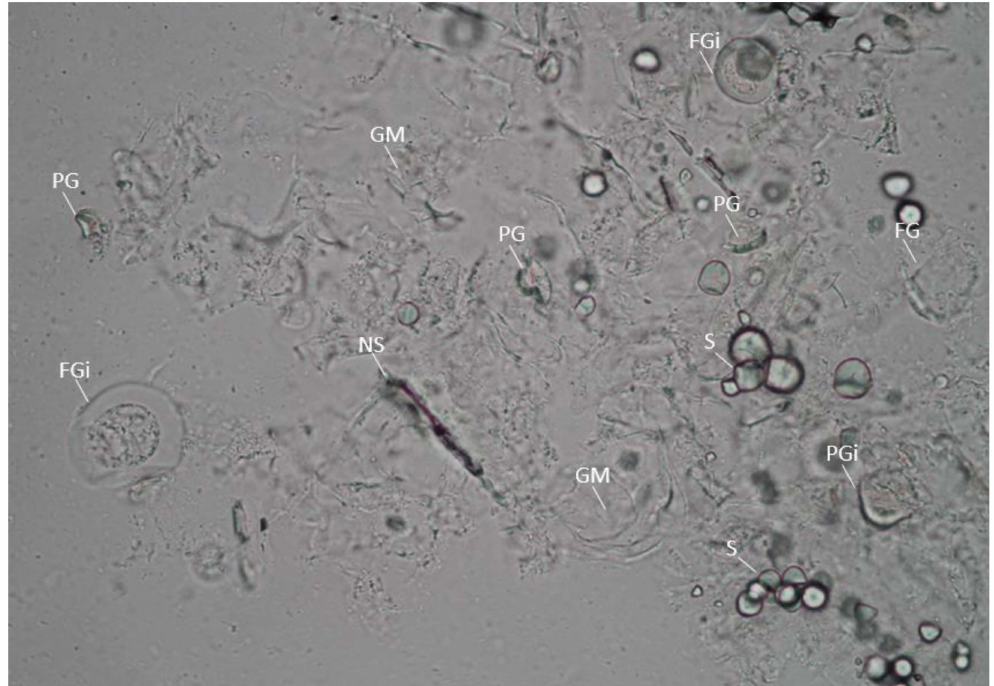
Figure 3. Micrograph at 400 × of gelatinous layer produced after PEF 2 at 500 kJ/kg treatment of cassava flour. Photo reveals a gelatinous matrix (GM) with visibly entrapped intact (FGi) and disintegrated fully gelatinized granule (FG), intact (PGi) and disintegrated partially gelatinized granule (PG), native starch (S) and non-starch (NS)